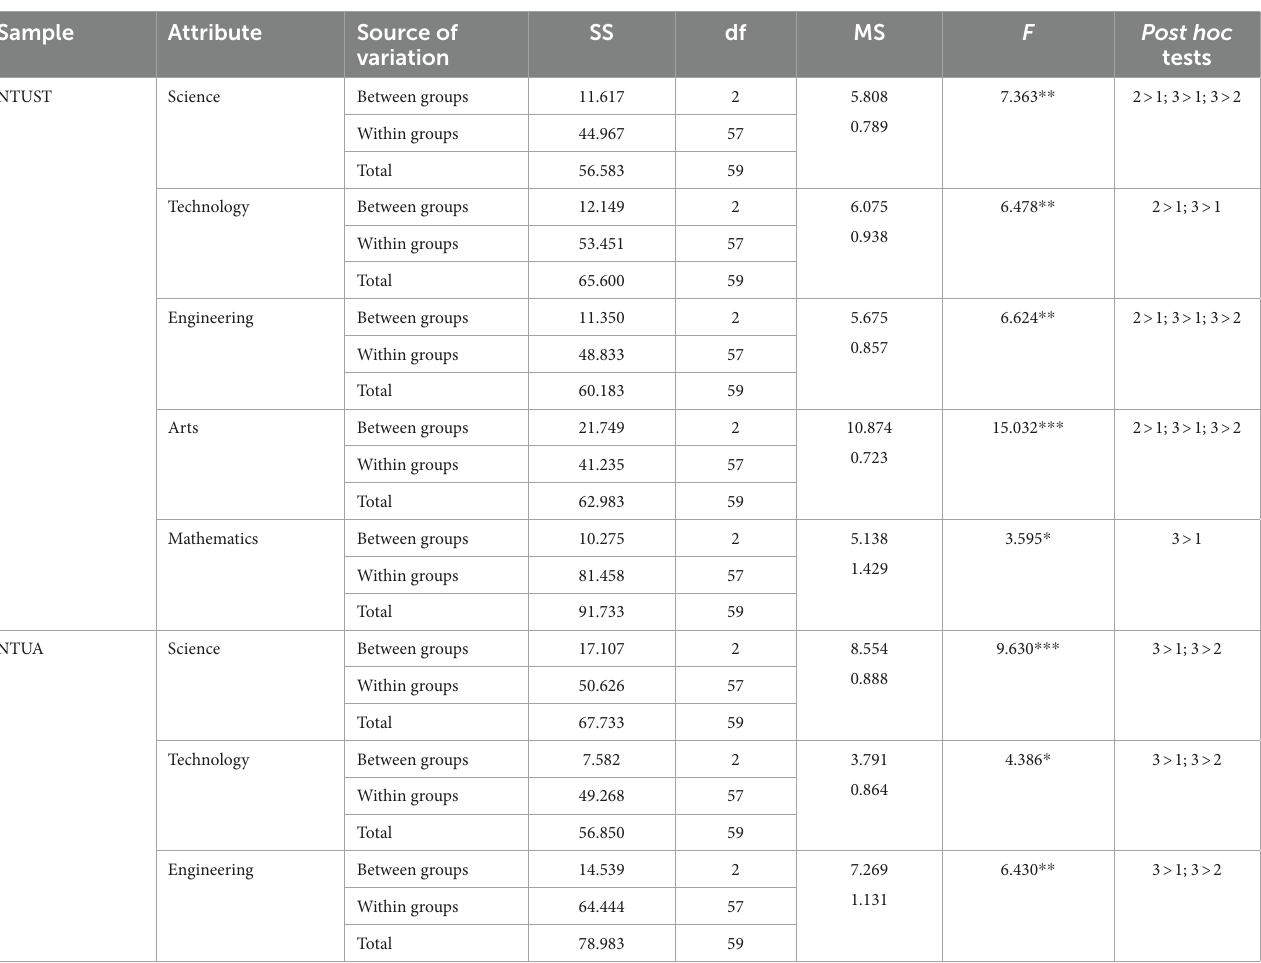
TABLE 9 A comparison of NTUA and NTUST assessments by subjects from NTUST.